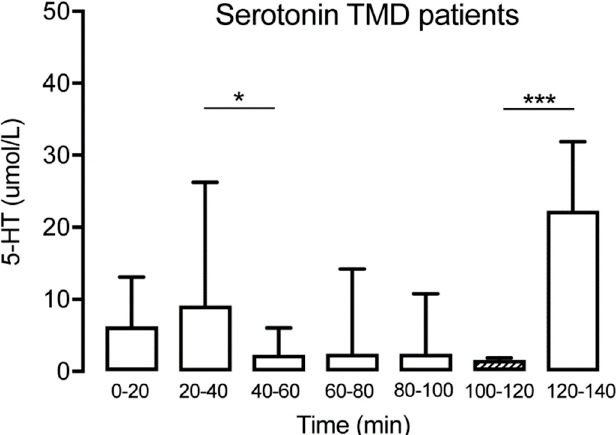
Figure 2. Interstitial serotonin at different time points for the healthy control group ( n = 15) showing no significant alteration over time. The hatched box indicates time point T100–120, often used as a baseline.